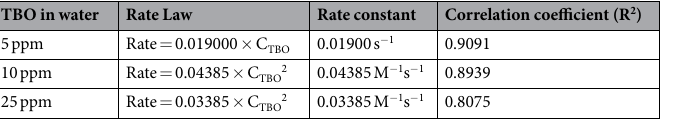
Table 2. Kinetics governing the generation of singlet oxygen from TBO in water * . * C TBO : Concentration of TBO.